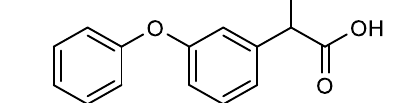
Figure 1. Chemical structure of